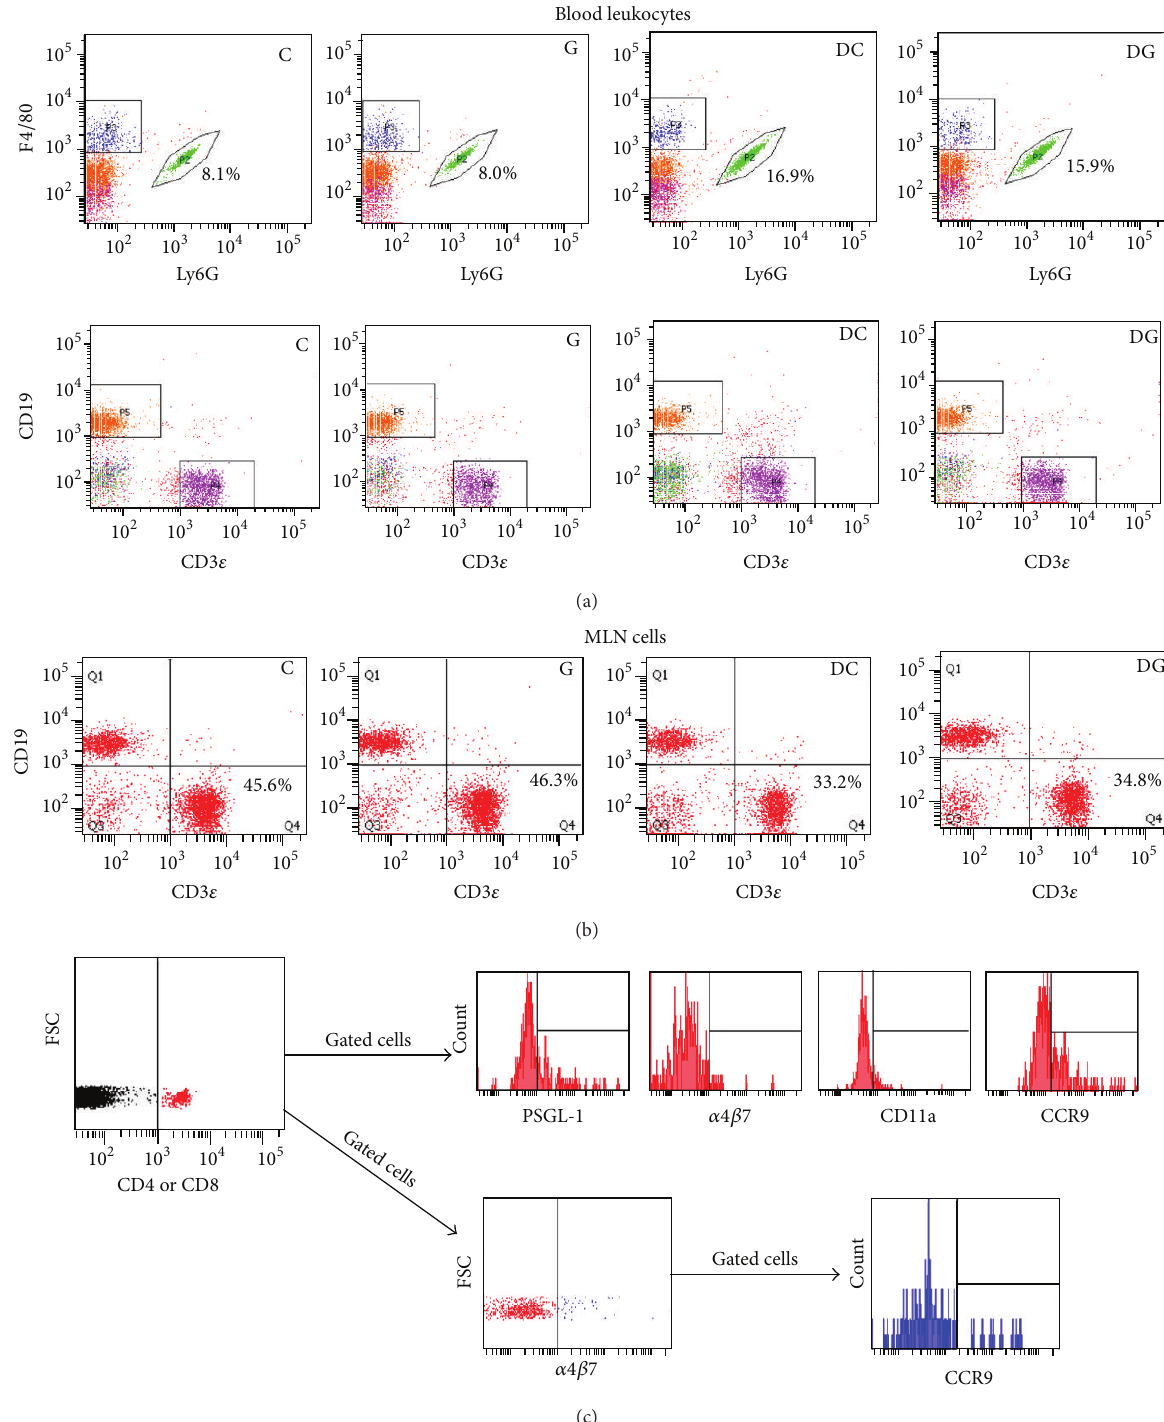
Figure 2: Representative flow cytometry plots. Blood leukocytes (a) were defined by gating on CD45-positive cells. The percentage of Ly6G- positive neutrophils from an individual representative mouse per group is listed. For analyzing the lymphocyte population in MLNs (b), MLN cells were first gated to exclude debris. Numbers indicate the percentage of CD3 𝜀 -positive lymphocytes in MLN cells. For analyzing the expression of adhesion molecules and chemokine receptors by T cells (c), lymphocytes were first identified based on low FSC and SSC characteristics. CD4- or CD8-positive lymphocytes were gated to analyze the percentages of adhesion molecule- and chemokine receptor- expressing CD4 + and CD8 + lymphocytes. Representative dot plots of leukocytes in blood are